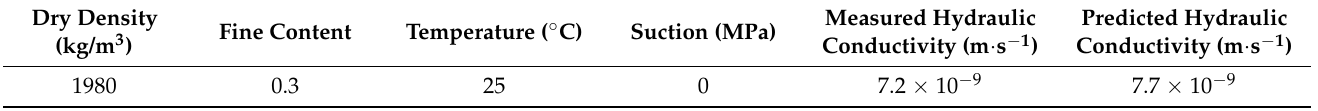
Table 2. Comparison of the measured and predicted hydraulic